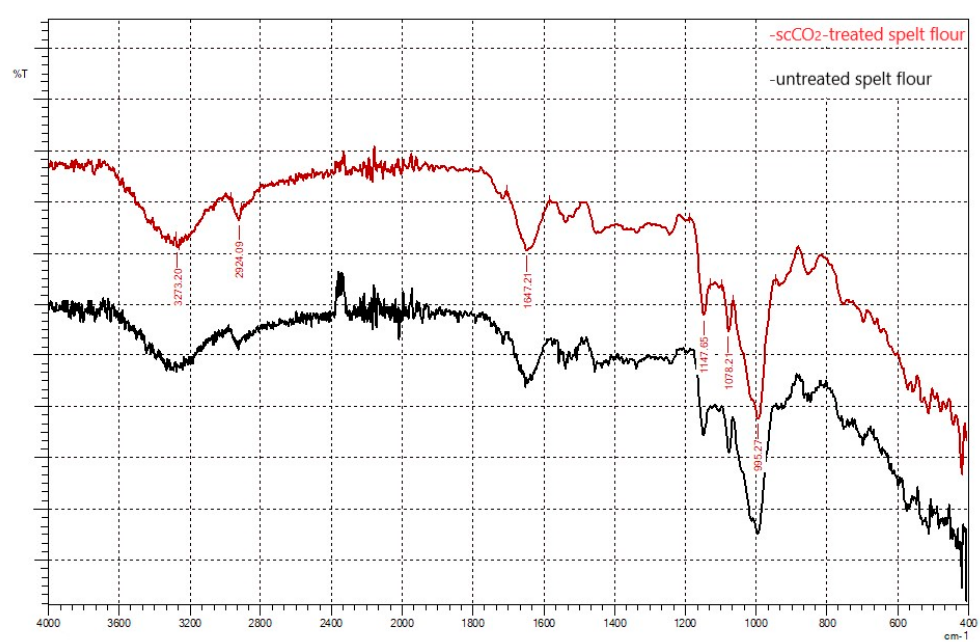
Figure 4. FTIR patterns of the untreated spelt flour (black) and scCO 2 -treated spelt flour (red). Taken together, these data demonstrate that there was no change in the intensity of the characteristic peaks of FTIR spectrum, which means that scCO 2 does not affect major functional groups of spelt